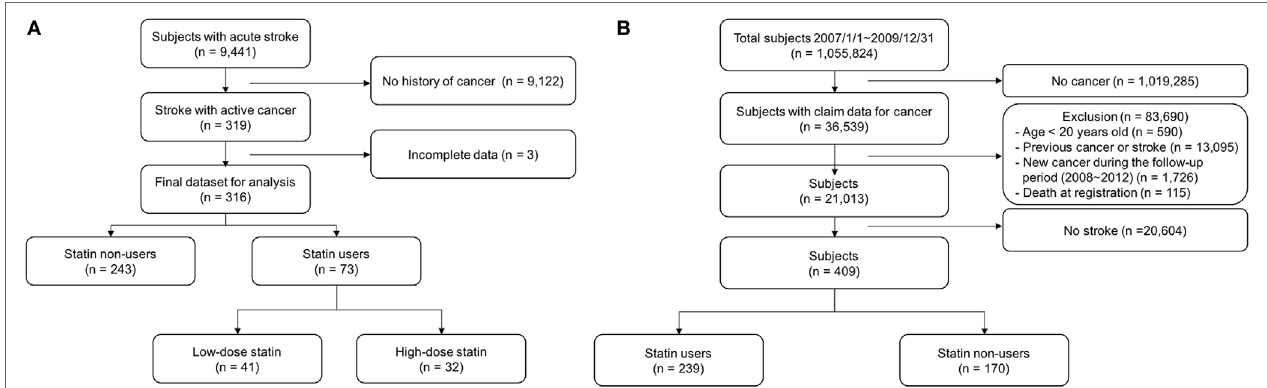
FigUre 1 | Flow chart for patient selection from the stroke registry cohort (a) and National Health Insurance-National Sample Cohort database (B)